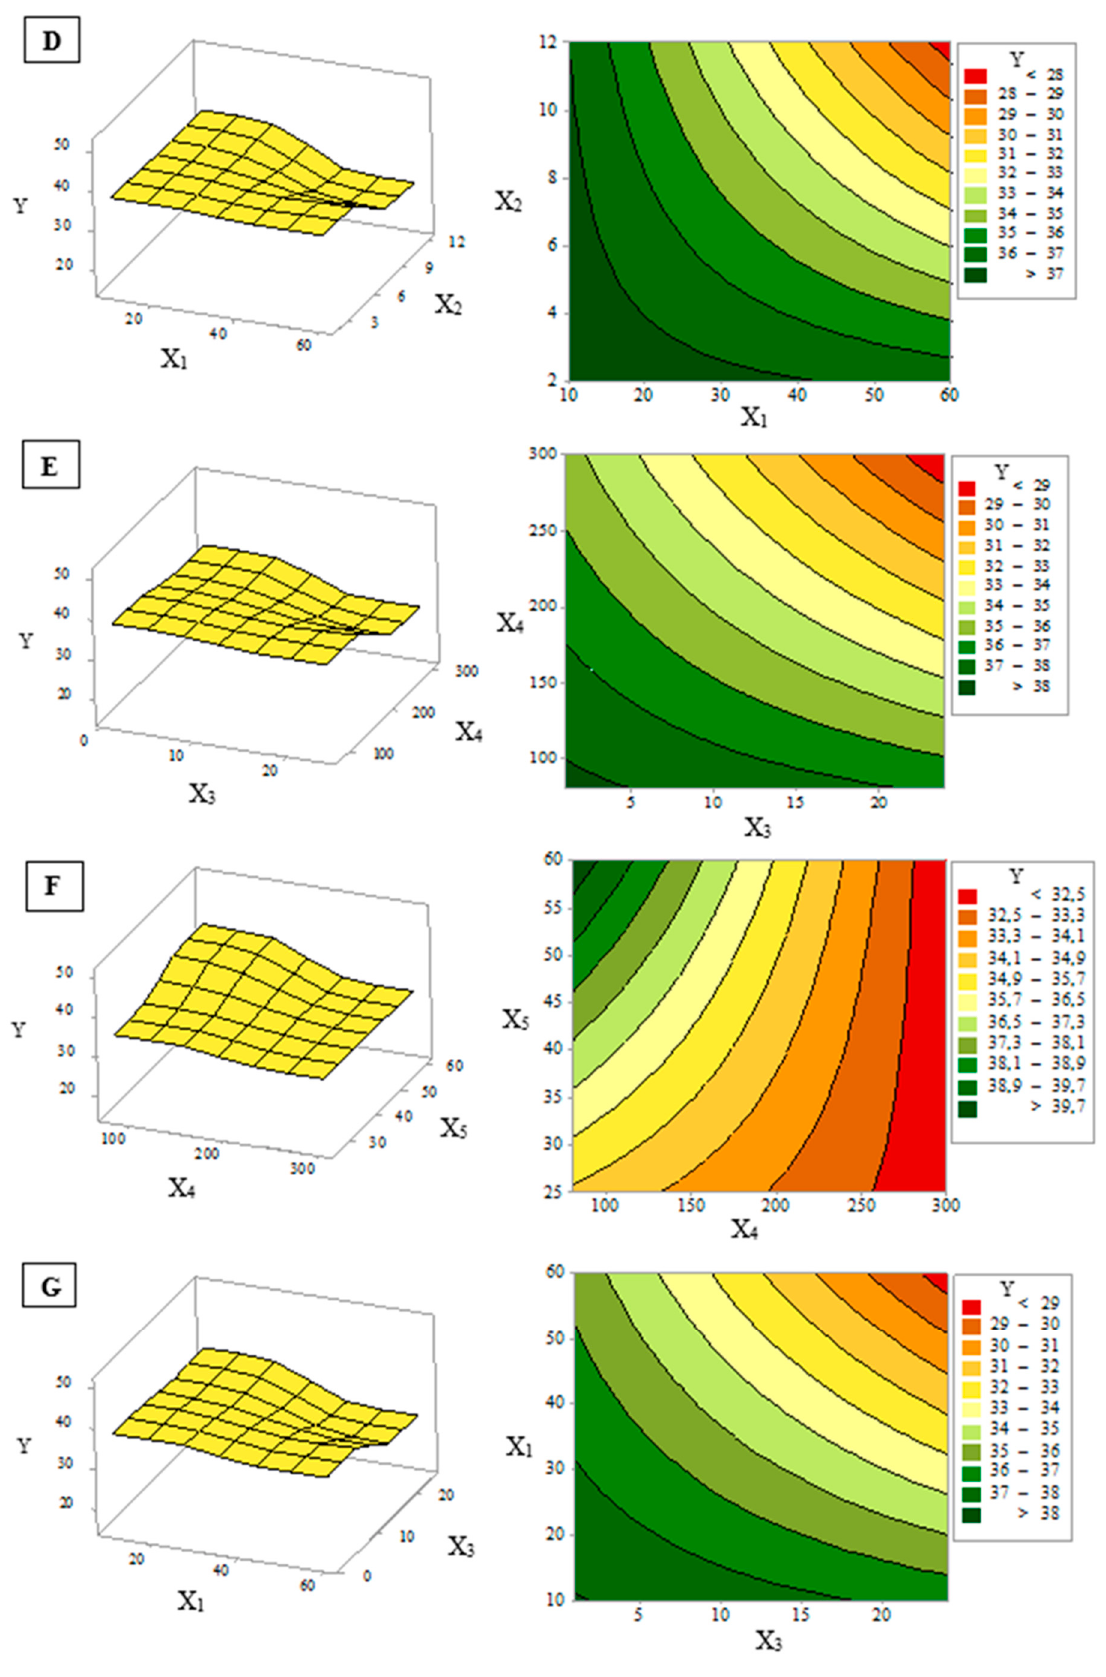
Figure 4. ( A – G ): Response surface and contour plots for the % Rem.